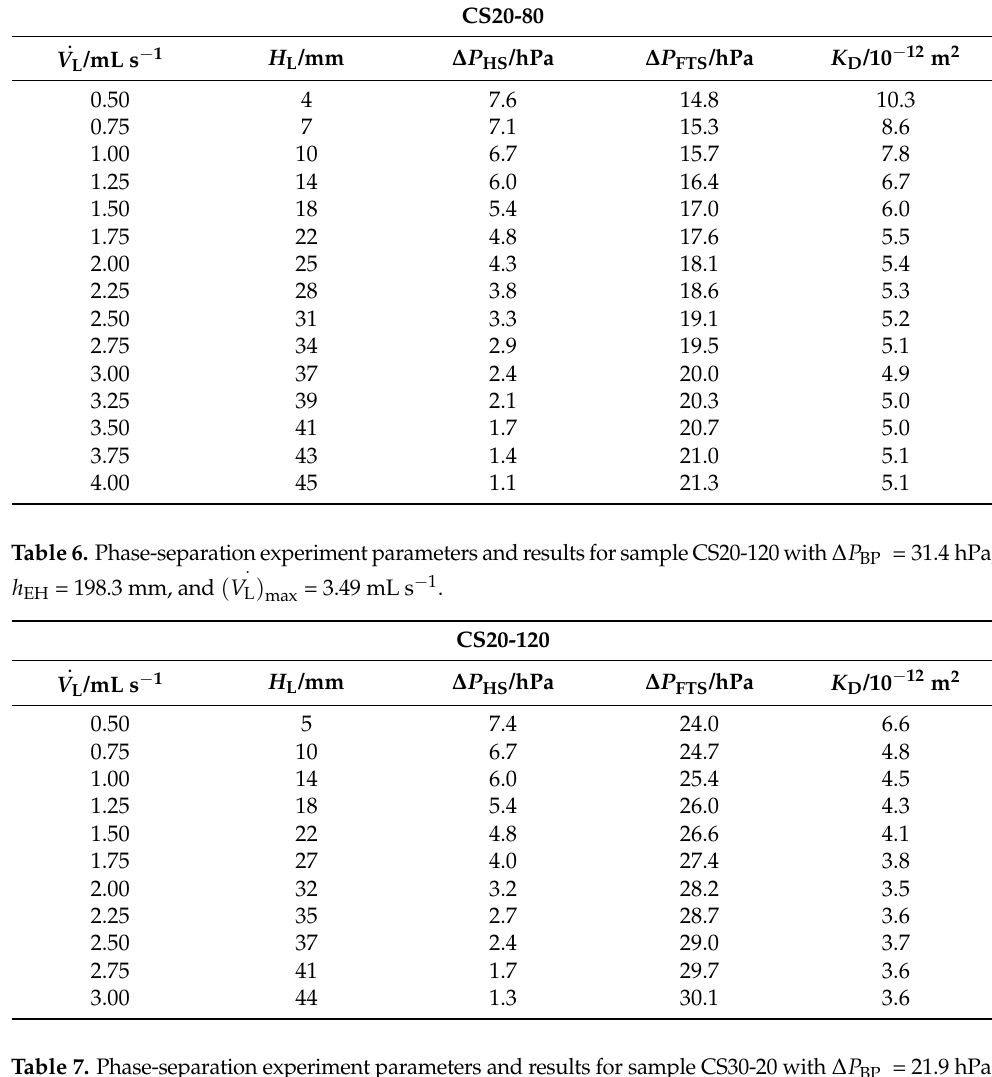
Table 7. Phase-separation experiment parameters and results for sample CS30-20 with ∆ P BP = 21.9